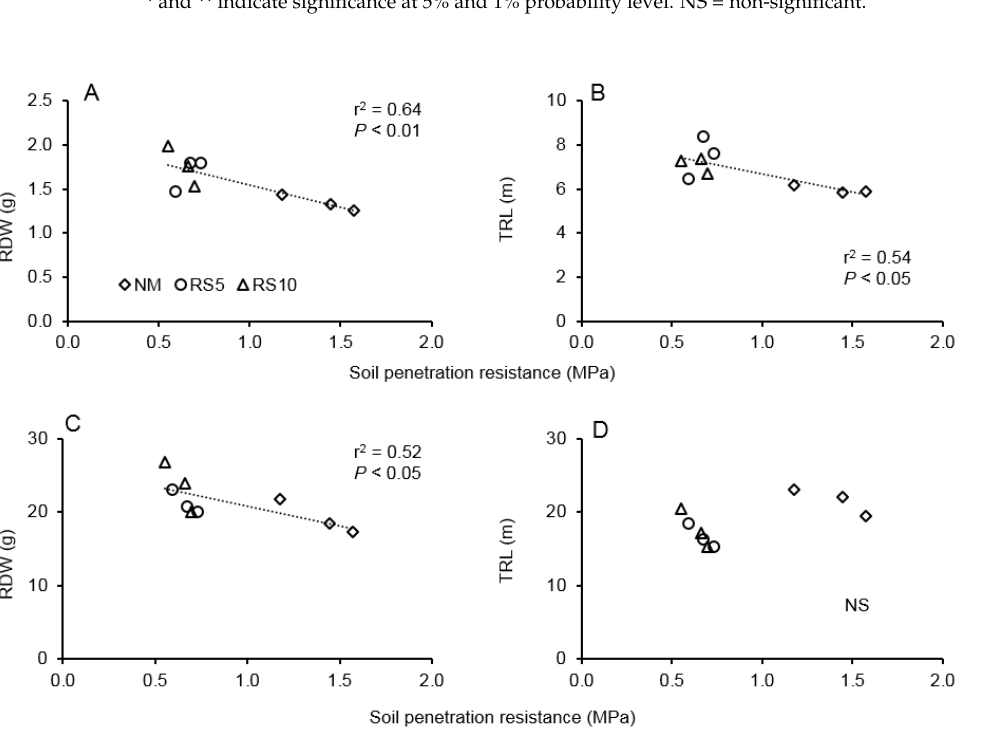
Figure 9. Relationship between average soil penetration resistance (0–30 cm) and root parameters in 2018–2019: ( A ) total root dry weight (RDW), ( B ) total root length (TRL) at bud formation, and ( C ) total root dry weight, ( D ) total root length at flowering. NM = no-mulch; RS5 = rice straw ~5 t ha − 1 ; RS10 = rice straw ~10 t ha − 1 ; NS = non-significant.